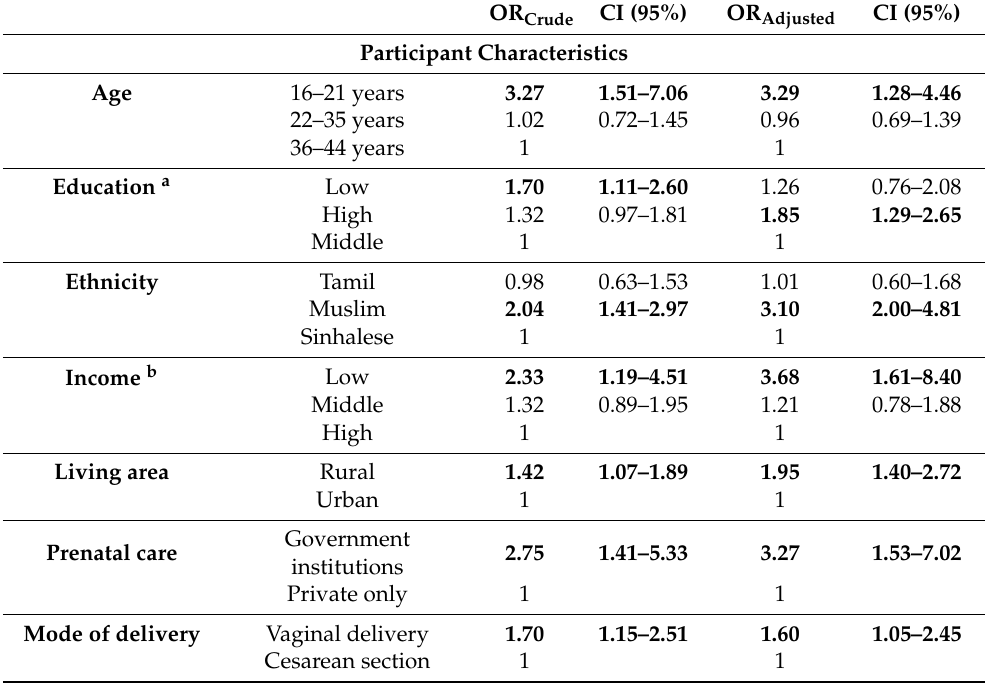
Table 4. Crude and adjusted odds ratio (OR) for obstetric violence * and associated factors adjusted for all included